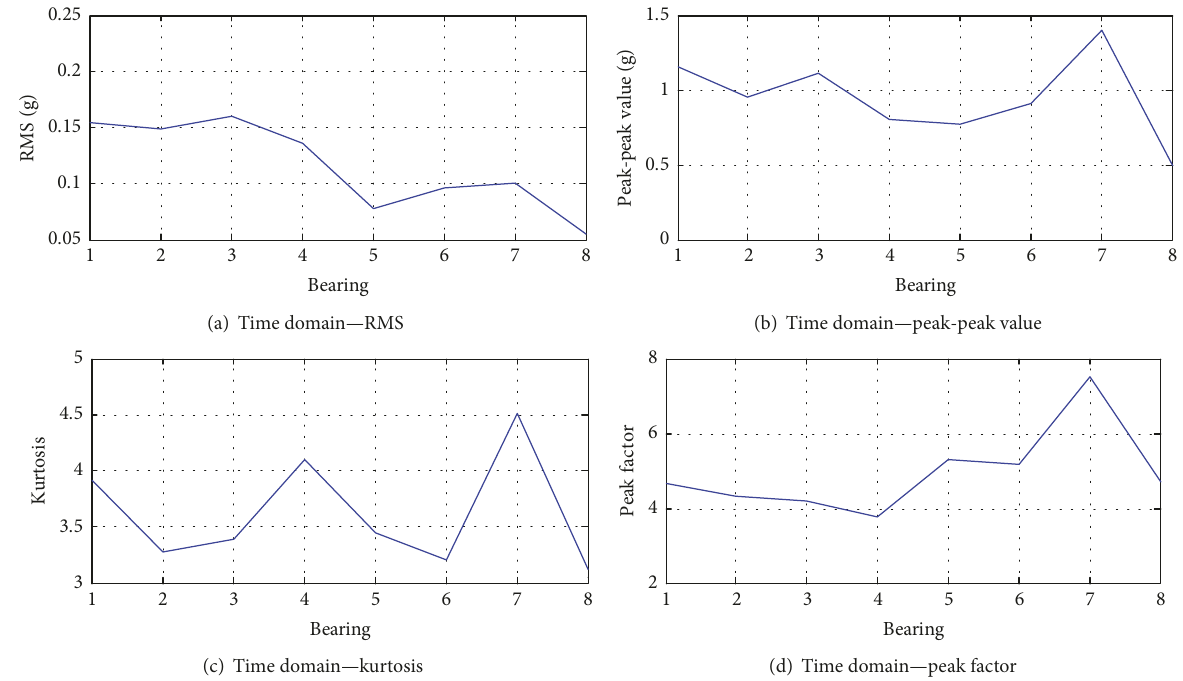
Figure 4: Mean time domain features in normal work